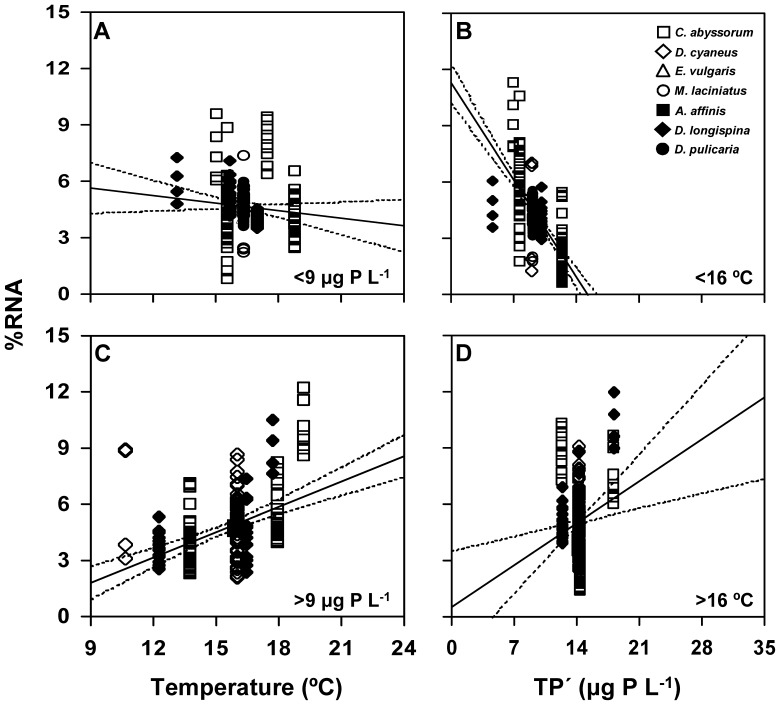
Partial regression plots for the relationships of lake temperature and phosphorus with RNA content for investigated zooplankton species.Relationships of temperature with RNA content (% of dry weight, %RNA) (A) below and (C) above the median value of lake phosphorus (TP′, 9 µg P L−1). Relationships of TP′ with %RNA (B) below and (D) above the median value of lake temperature (16°C). Each point represents single observations for each species. Copepod species are Cyclops (C.) abyssorum, Diaptomus (D.) cyaneus, Eudiaptomus (E.) vulgaris, and Mixodiaptomus (M.) laciniatus; and cladoceran species are Alona (A.) affinis, Daphnia (D.) longispina, and Daphnia (D.) pulicaria. Dotted lines indicate 95% confidence intervals around the fitted regression lines (solid lines).